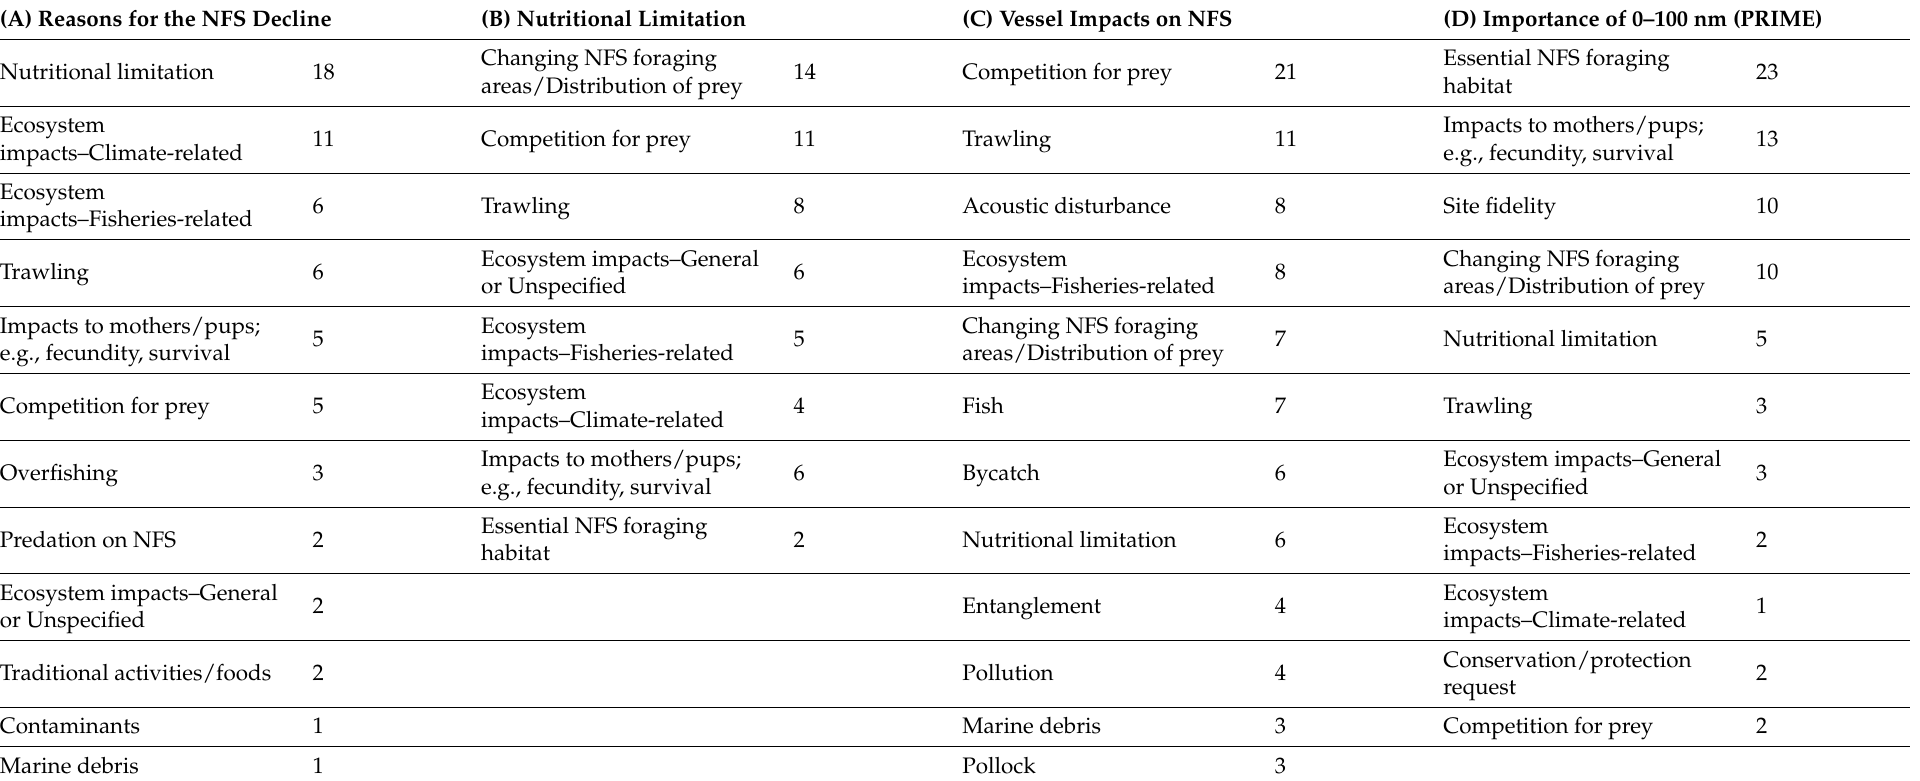
Table 1. Co-occurrence frequency for four themes explored in community surveys: ( A ) “Reasons for the northern fur seal (NFS) decline”, ( B ) “Nutritional limitation”, ( C ) “Vessel impacts on northern fur seals (NFS)”, and ( D ) “Importance of the 0–100 nm Pribilof Islands Marine Ecosystem